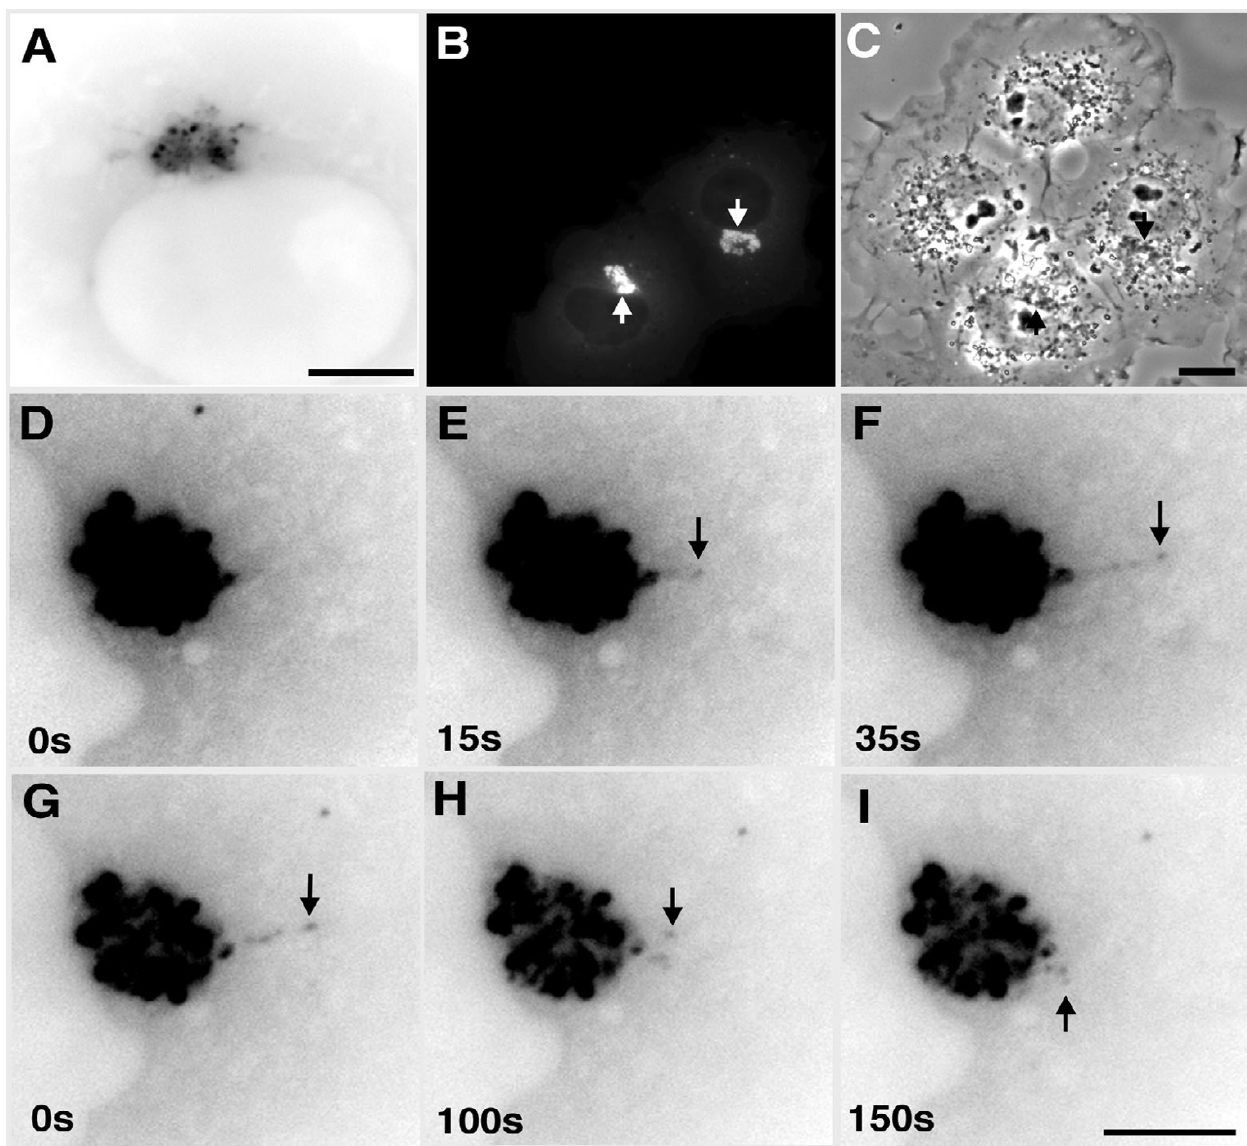
Figure 1 Live imaging of EB1- ∆ N2-GFP aggregates in transfected COS-7 cells. Panel A. Single frame from additional file 1 showing the structure of EB1- ∆ N2-GFP aggregates. Bar = 5 µ m. Panel B. Single frame from additional file 2, sequence 1 showing aggresome (arrows) behaviour in two transfected cells. Panel C. Single frame from additional file 2, sequence 2 that shows the cells from sequence 1 imaged using phase-contrast microscopy to reveal adjacent untransfected cells. This sequence was begun 30s after the completion of sequence 1. Arrows indicate aggresome location in the transfected cells. Bar = 10 µ m. Panels D-F. Three frames from additional file 3, sequence 1 showing the extension of a linear structure from an EB1- ∆ N2-GFP aggregate. Panels G-I. Three frames from additional file 3, sequence 2 showing the retraction of this structure. Bar for D-I = 5 µ m. Times shown are relative to the first frame in each sequence. Panels A and D-I were obtained using a 63X oil immersion lens. Panels B and C were obtained using a 40X dry